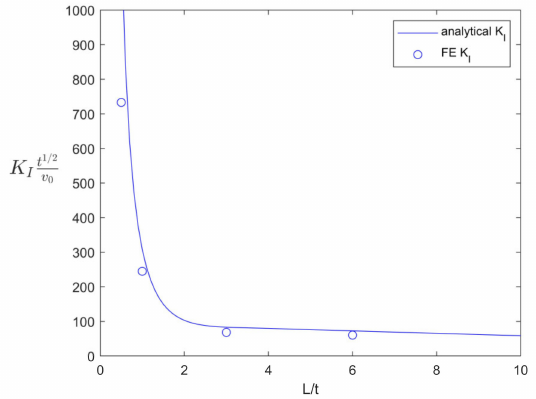
Figure 10. The SIF results: the analytical versus the FE results for the coach-peel test specimens.